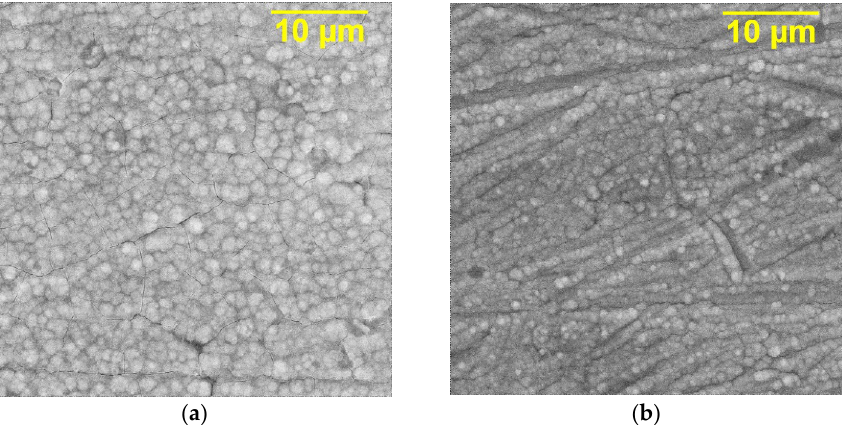
Figure 3. SEM images of the surface of the nickel–chromium alloy ( a ) and the CEC nickel–chromium–GO ( b ) deposited at cathodic current density i C = 10 A/dm 2 . Magnification ×5000.